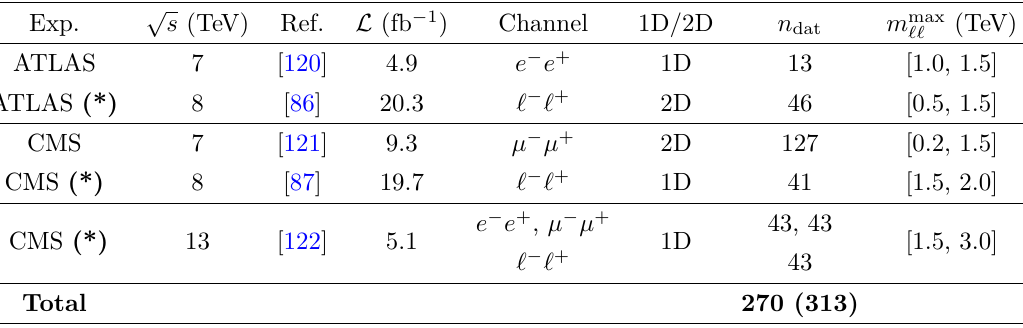
Table 2 . Same as table 1 for the neutral-current high-mass Drell-Yan datasets considered in this work. We also indicate the final-state, whether the distribution is 1D (which are differential in the invariant mass, m ‘‘ , of the final-state leptons) or 2D (which are differential in both the invariant mass of the leptons, m ‘‘ , and in their rapidity, y ‘‘ ), and the values of m ‘‘ for the most energetic bin. Datasets indicated with (*) are used for the first time in this analysis in comparison with [95]. theoretical predictions for the DY electron data would be those of the SM while those of the muon data should include EFT corrections. On the other hand in the